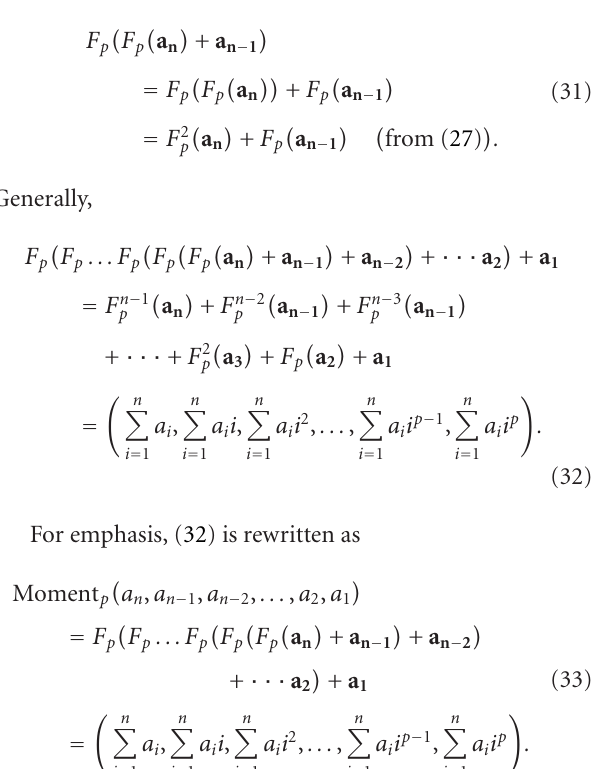
Algorithm 2: The algorithm for computing X ( k